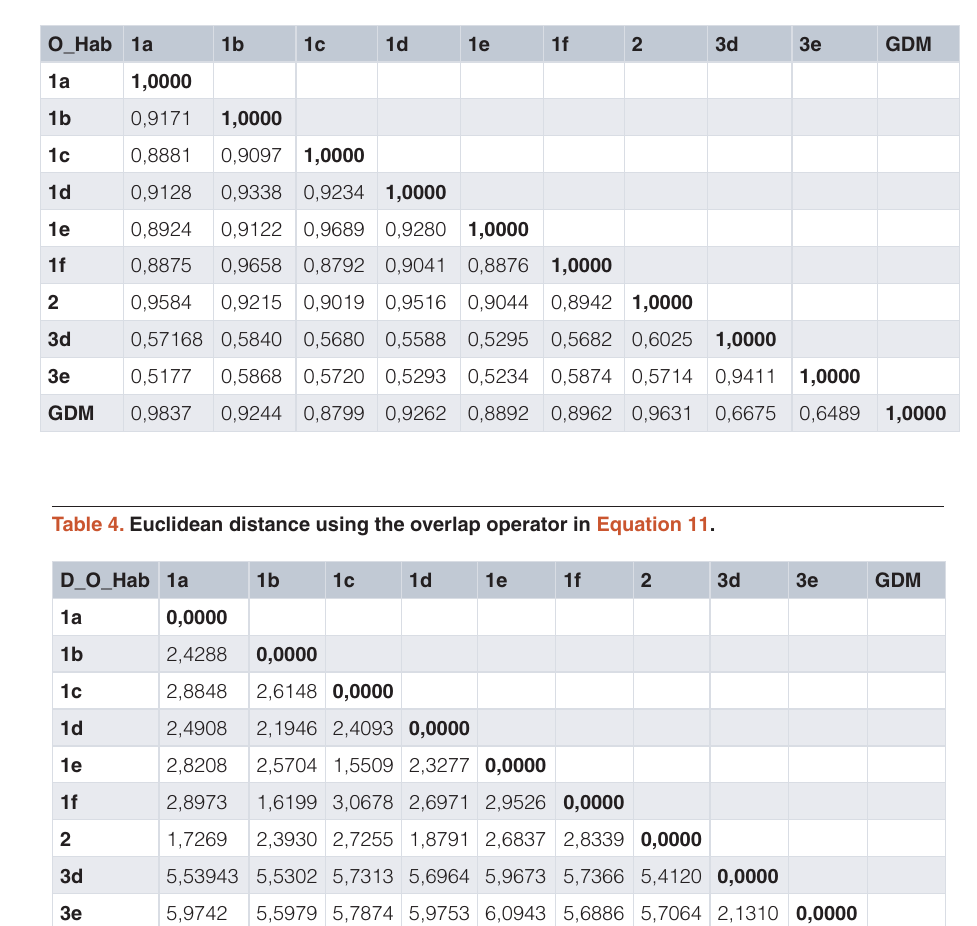
Table 3. Molecular quantum similarity indices using the overlap operator in Equation 12.